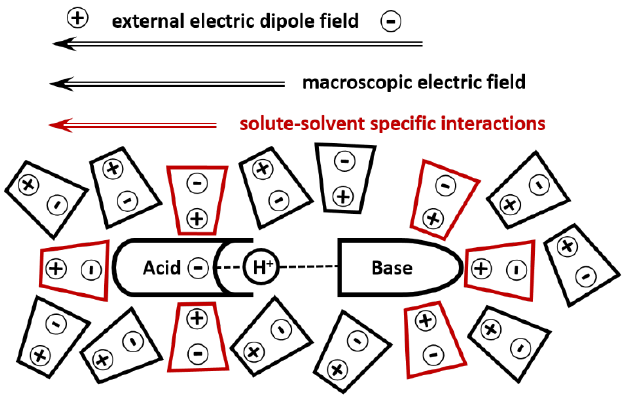
Figure 1. The direction of the external electric field that simulates the effect of solute–solvent interactions on the H-bond.